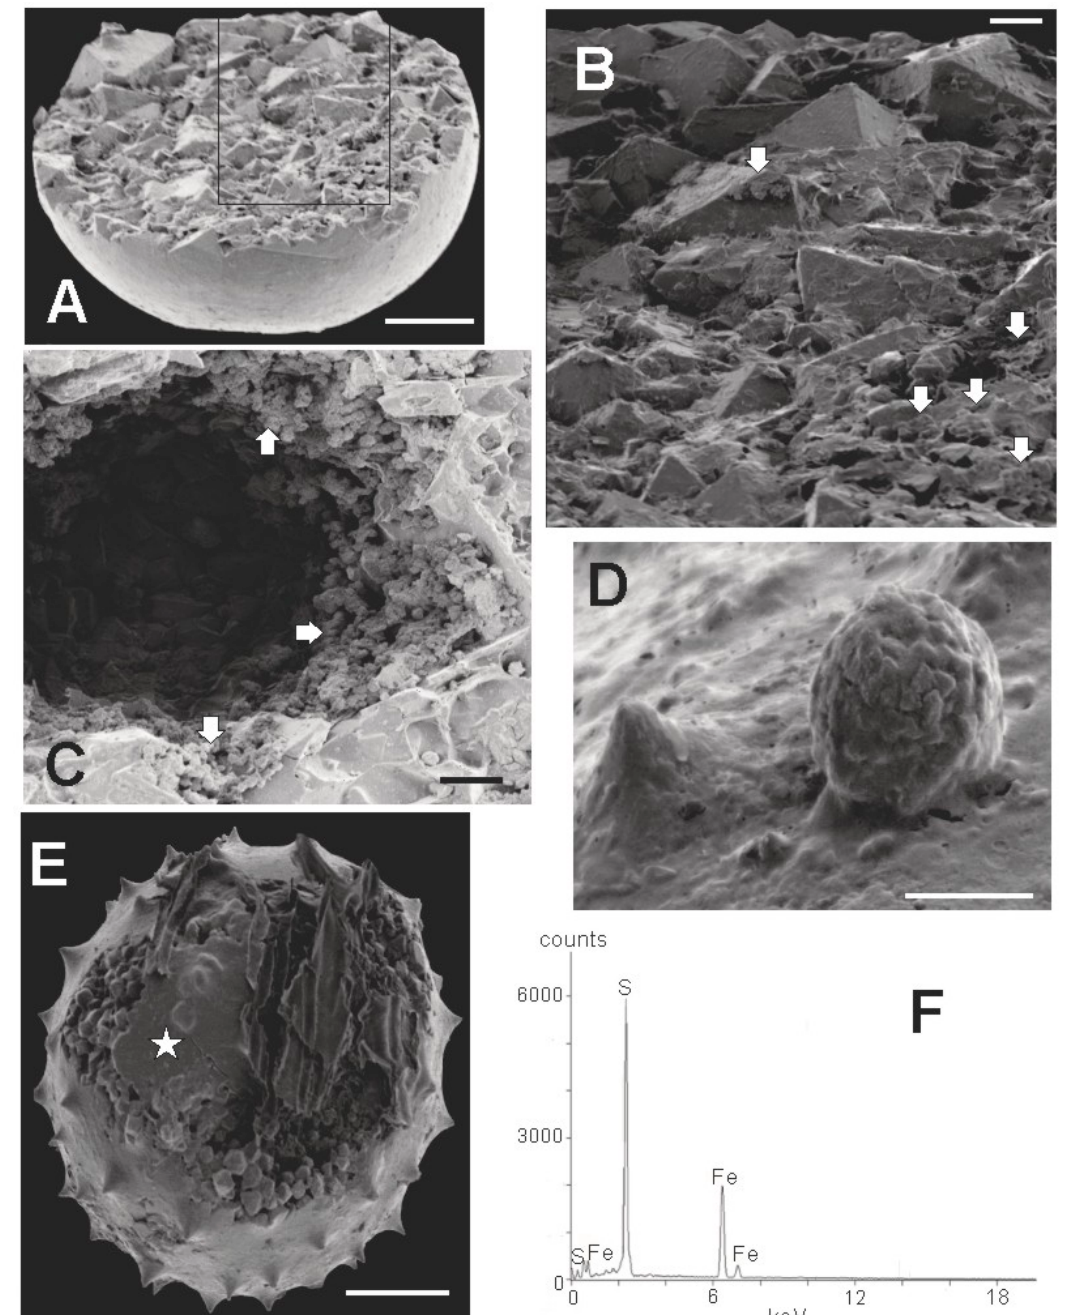
Figure 9. Composition of specimens extracted from rock matrix. Scale bar in A = 50 µ m. Scale bar in B: 10 µ m. Scale bar in C, D = 5 µ m. Scale bar in E = 20 µ m ( A ) SEM image of incompletely preserved sphaeromorphic specimen (TYS-16) showing an interior filled with cubic and pyramidal crystals of pyrite. Box outline is the perimeter of the enlargement shown in B; ( B ) Detail of crystalline surface showing large euhedral pyrite crystals and smaller pyrite framboids (white arrows); ( C ) Detail of a large open space within the interior of a sphaeromorphic specimen (TYS-17) showing clusters of framboids lining the space (white arrows) and large euhedral crystals at the bottom of the opening; ( D ) Spheroidal framboid with individual crystallites of 1 µ m or less growing from the surface of an acanthomorphic specimen (TYS-45); ( E ) Acanthomorphic specimen (TYS-41) filled with euhedral pyrite crystals. Star shows the target area of the x-ray beam producing the spectrograph illustrated in F; ( F ) X-ray signature of smooth surface at position of star in E. Main peaks are those of iron and sulfur.